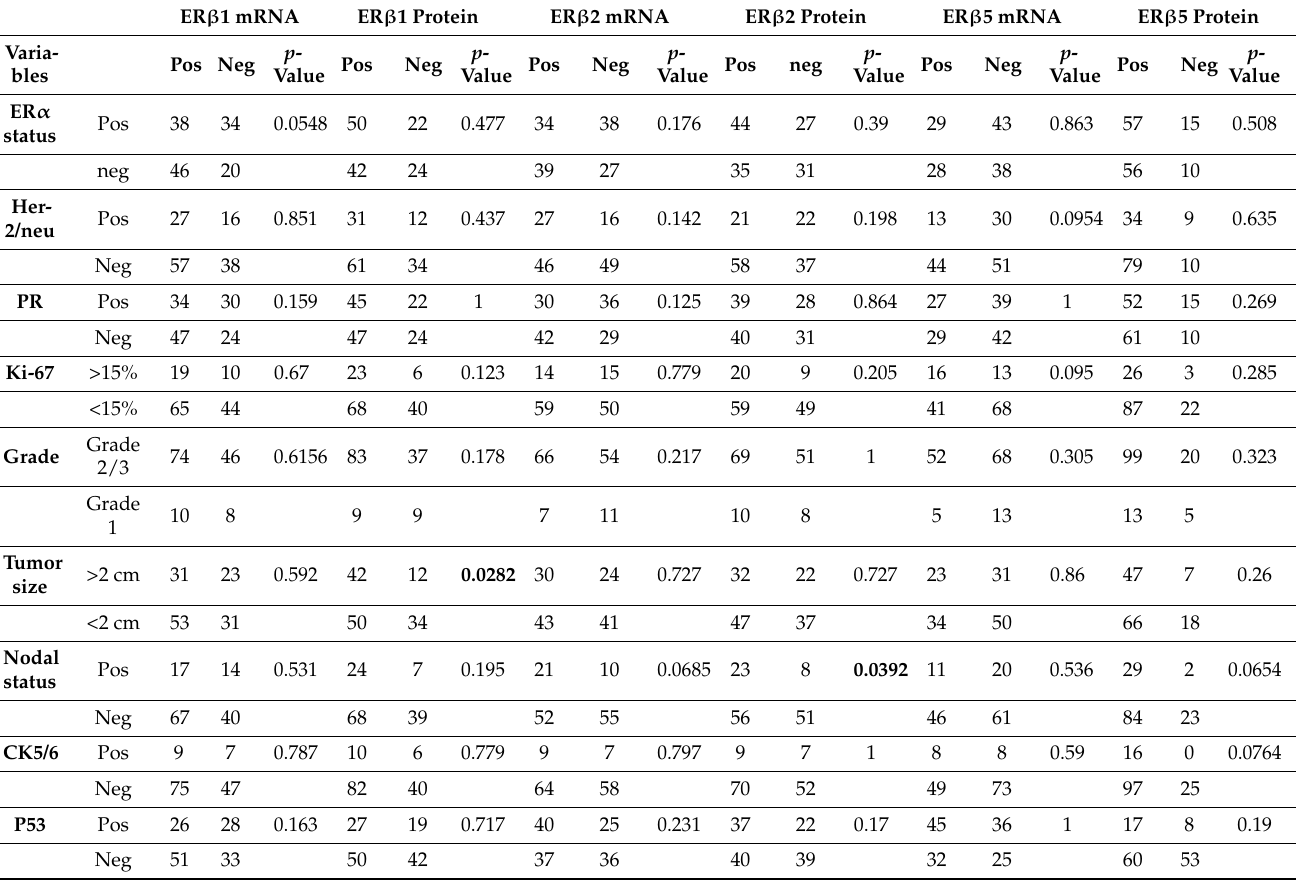
Table 2. Associations between ER β isoform mRNA and protein expression and clinical